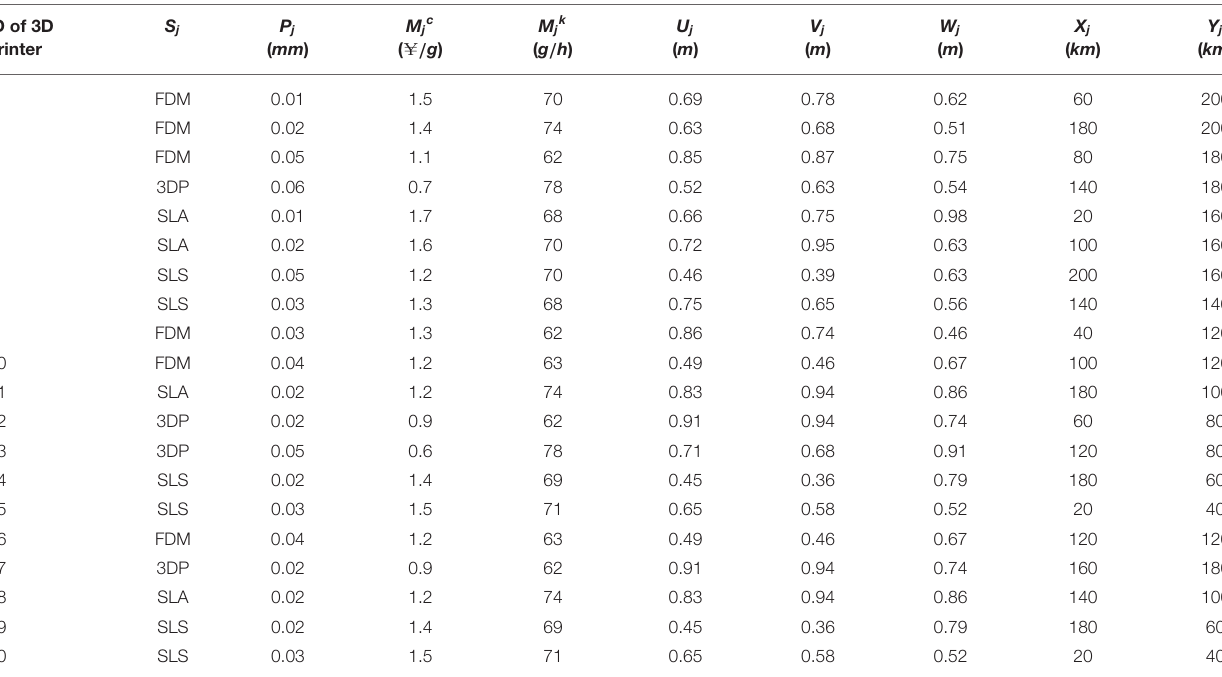
TABLE 3 | 3D printing device